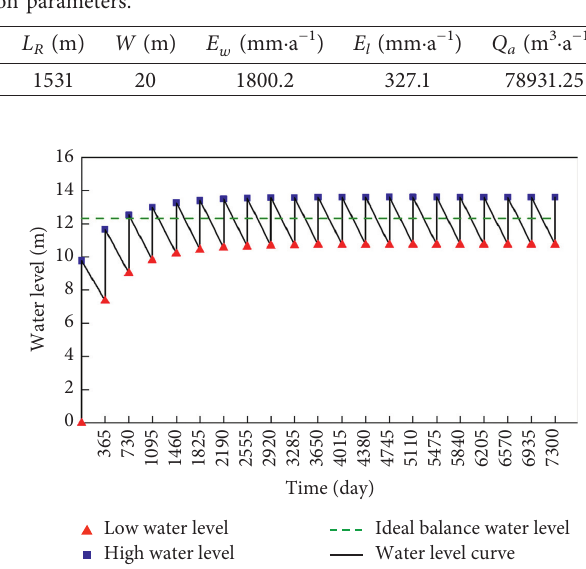
Figure 7: Water level fluctuation when an instantaneous rainfall enters the reservoir under the extreme conditions each year.